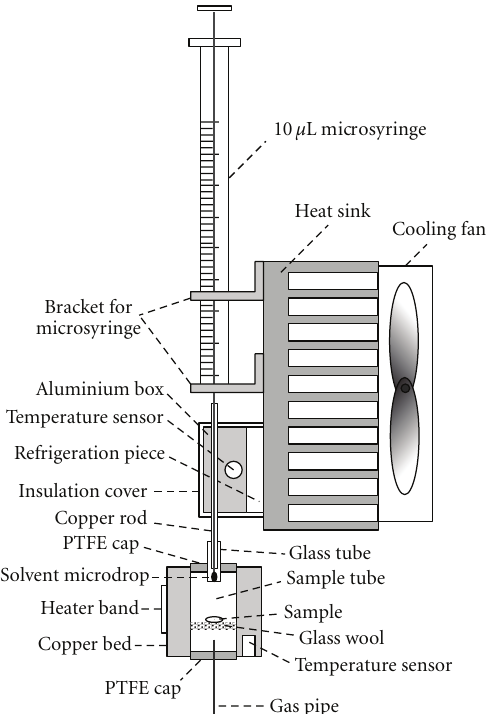
Figure 1: Schematic of the semiconductor condenser and heater in GP-HS-LPME